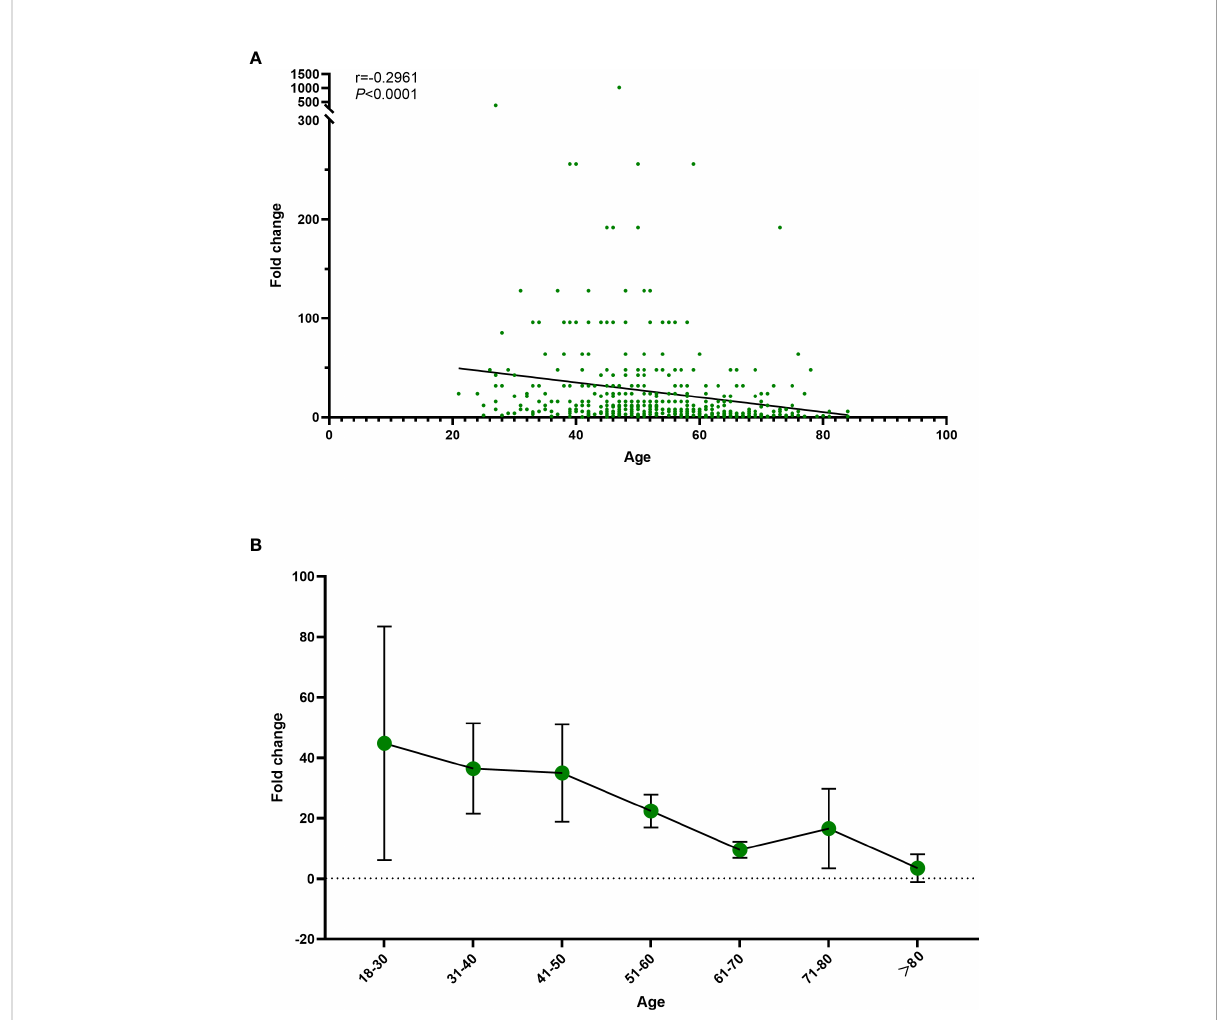
FIGURE 5 Association of age with the fold change in neutralizing antibody titers. (A) Correlation between the fold change in neutralizing antibody titers and age. (B) Trend in the fold change in neutralizing antibody titers with age. Fold change= Ratio of neutralizing antibodies before and after vaccination. r; Spearmen correlation coef fi